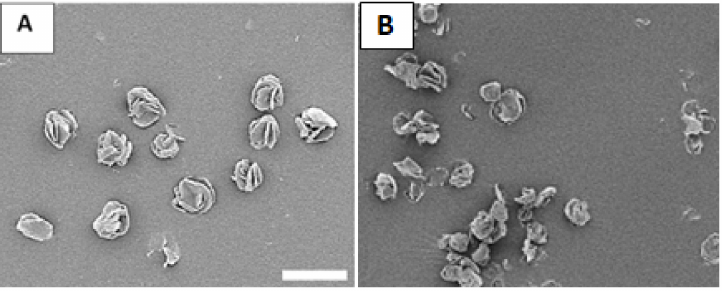
Figure 10. SEM images of the ILDF particles ( A ) freshly prepared; and ( B ) after 24 weeks of exposure in ambient conditions. Scale bar is 20 µ